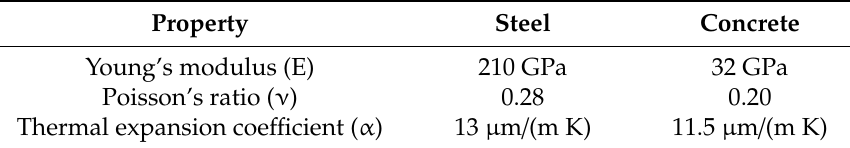
Table 1. The material properties considered in the analyses.